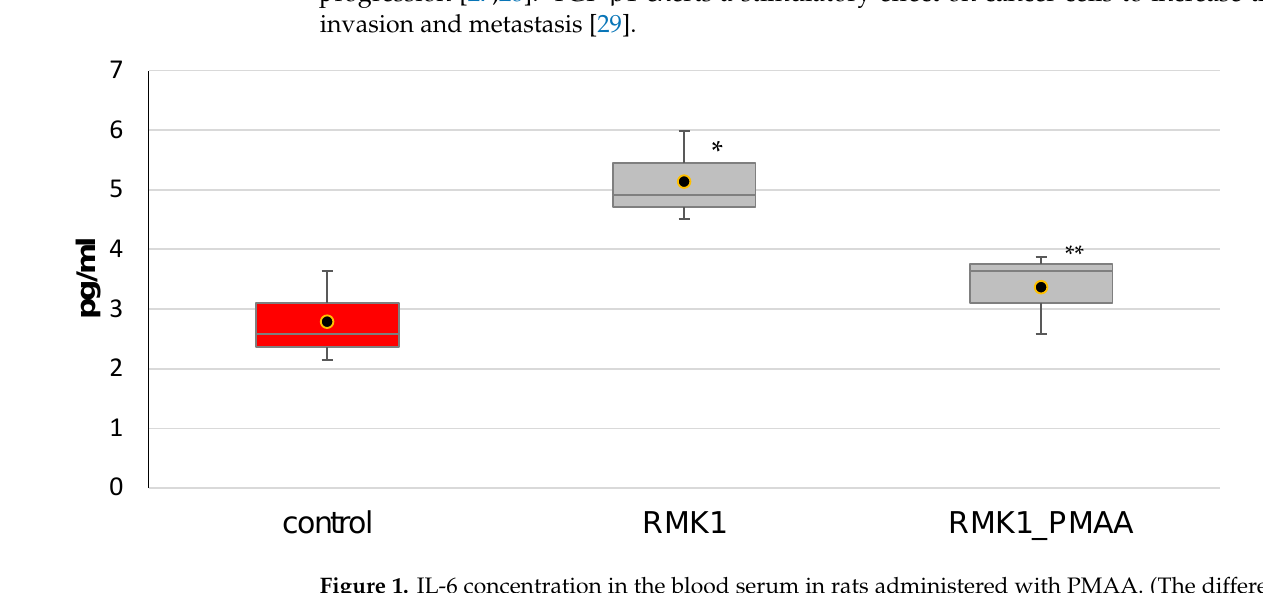
Figure 1. IL-6 concentration in the blood serum in rats administered with PMAA. (The difference from (*) intact rats or (**) control RMK1 tumor-bearing rats was significant at p < 0.05). As for IL-10, impairment of the antitumor immune response in the tumor microen-